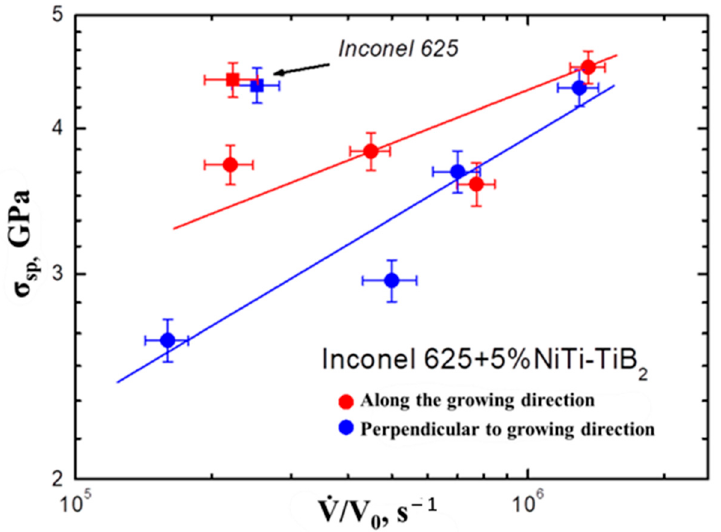
Figure 6. Dependency of the spall strength of the 95% Inconel 625 + 5% NiTi–TiB 2 AM alloy on the strain rate before spalling. The data for pure Inconel 625 alloy were taken from [27]. Table 1. The conditions and results of the experiments carried out with a PP50 pneumatic gun, and